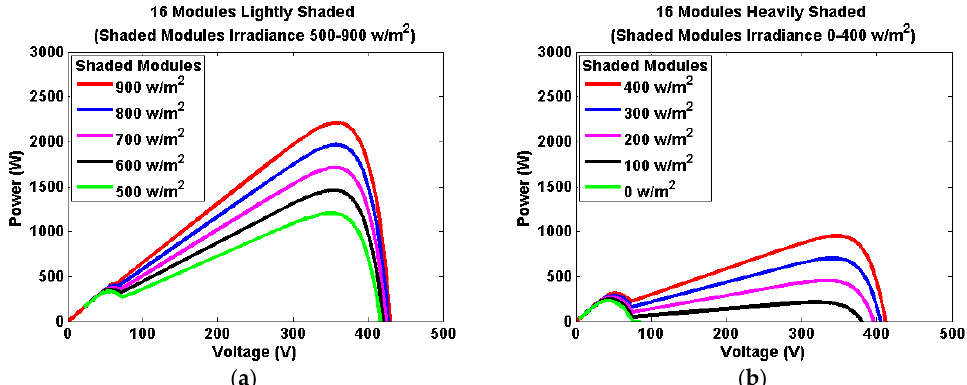
Figure 11. P-V characteristics of the 16 modules shaded setups: ( a ) shaded modules irradiance is between 500 and 900 w/m 2 ; ( b ) shaded modules irradiance is between 0 and 400 w/m 2 .